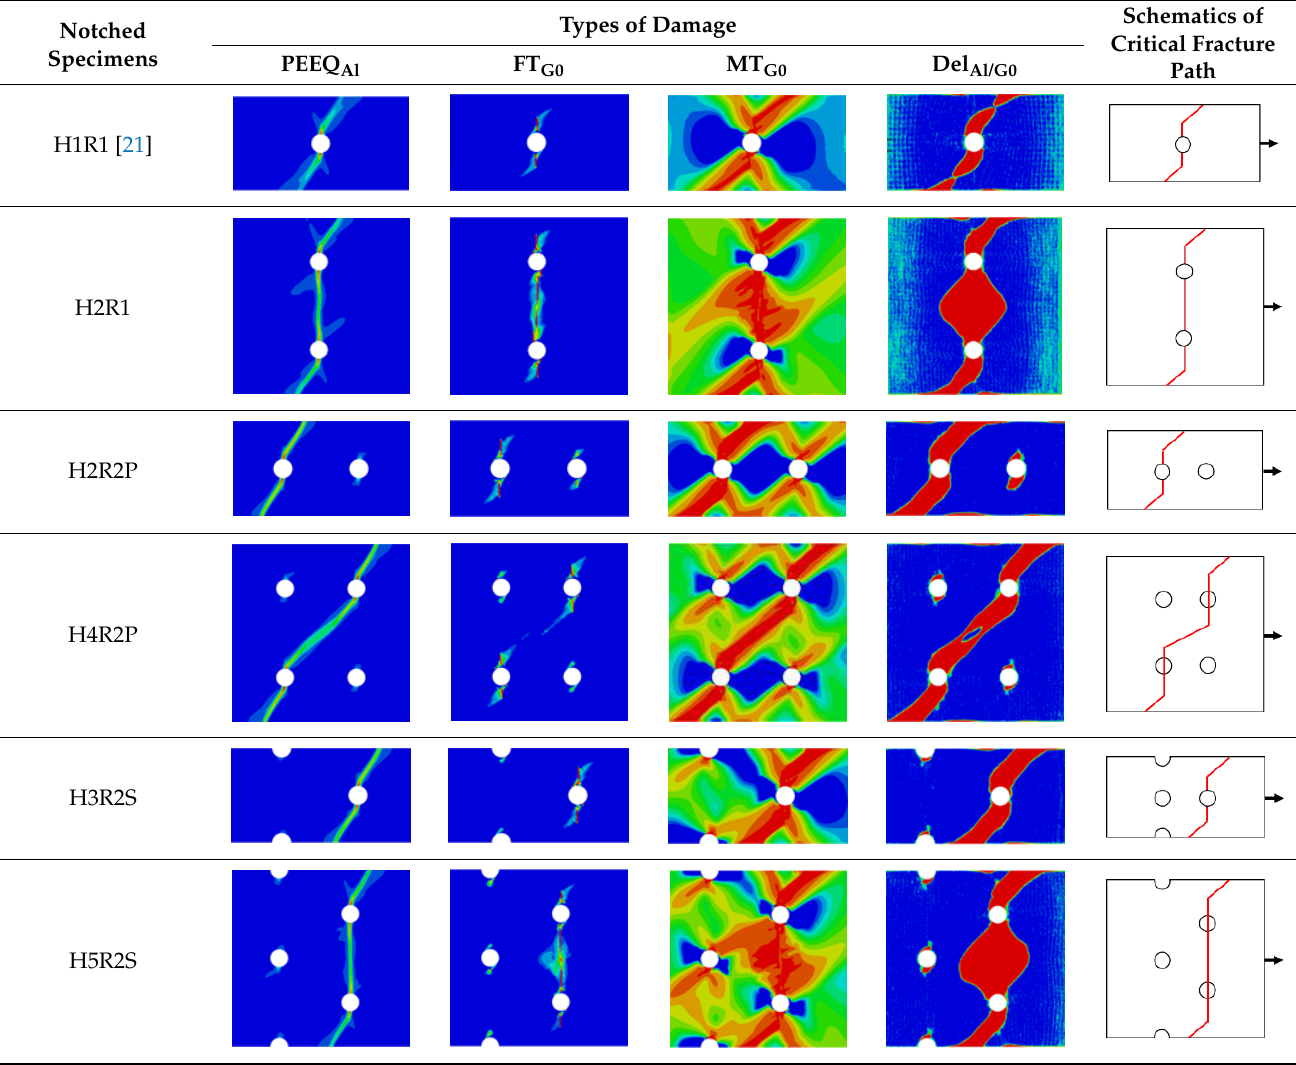
Table 8. Damage patterns of off-axis Glare with different hole arrangements.